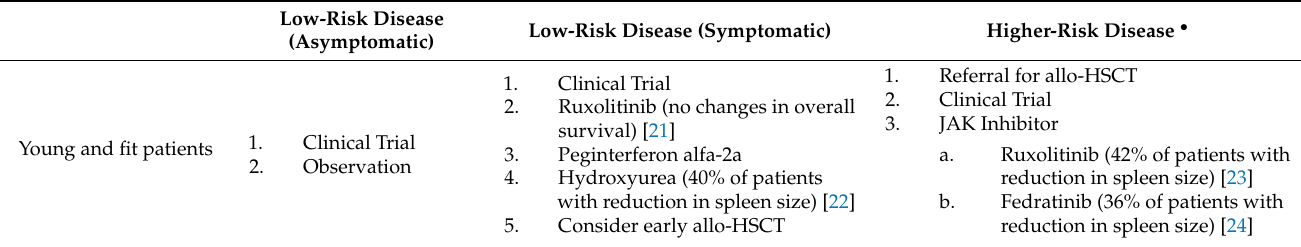
Table 2. Initial Treatment for PMF According to Disease